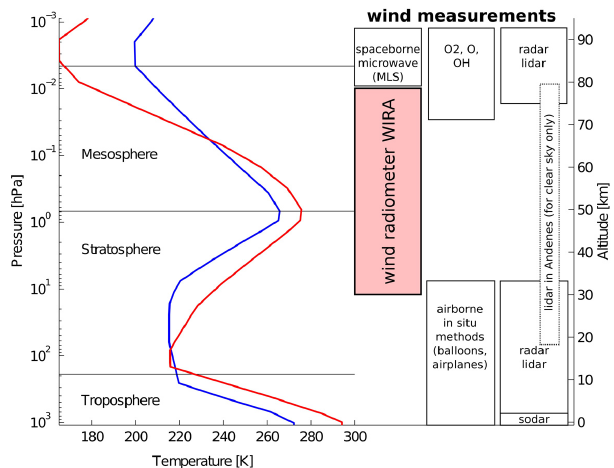
Fig. 2. Overview of the existing wind measurement techniques with their sensitive altitude range compared to the new wind radiometer WIRA. The blue and the red curve represent the temperature pro- file for mid-latitude winter and summer standard atmospheres. Un- der special conditions incoherent scatter radars may also be able to measure down to about 60km. Rocket measurements are not shown as they are only operated on campaign